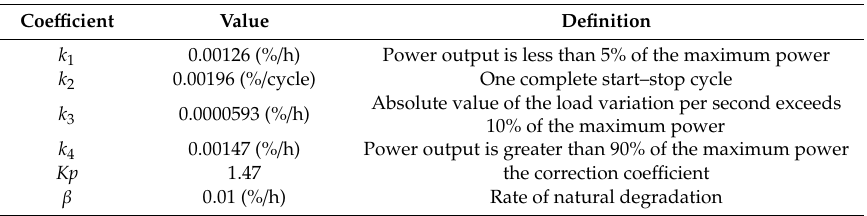
Table 2. Values of the coe ffi cients in Equation